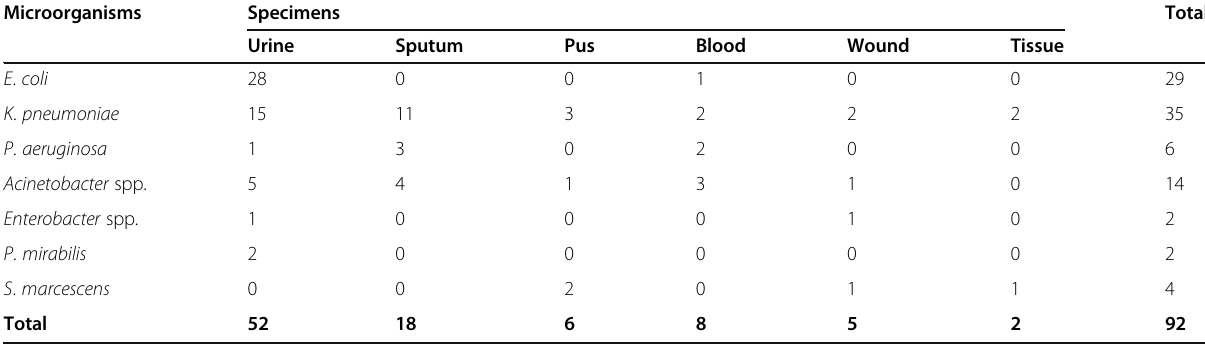
Table 1 Sample-wise distribution of isolates